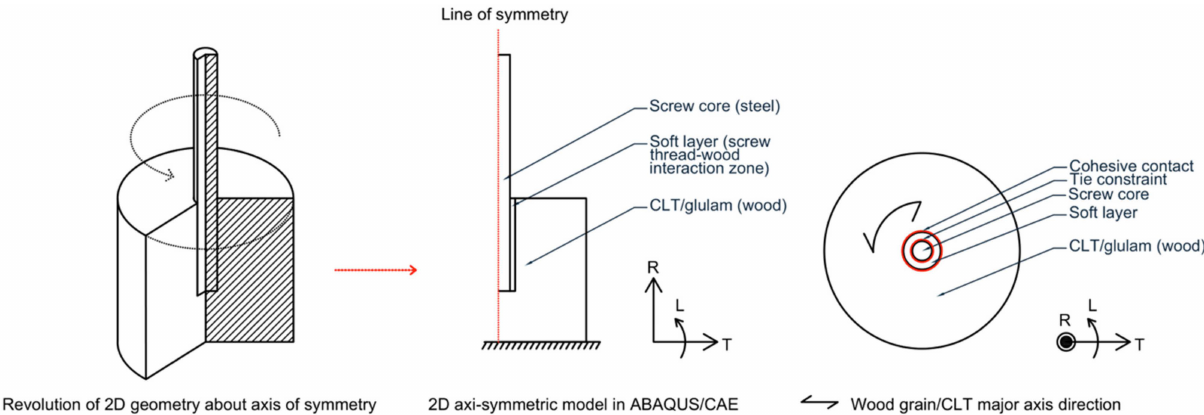
Figure 7. Reduction of the wood-screw 3D system to an axisymmetric system.